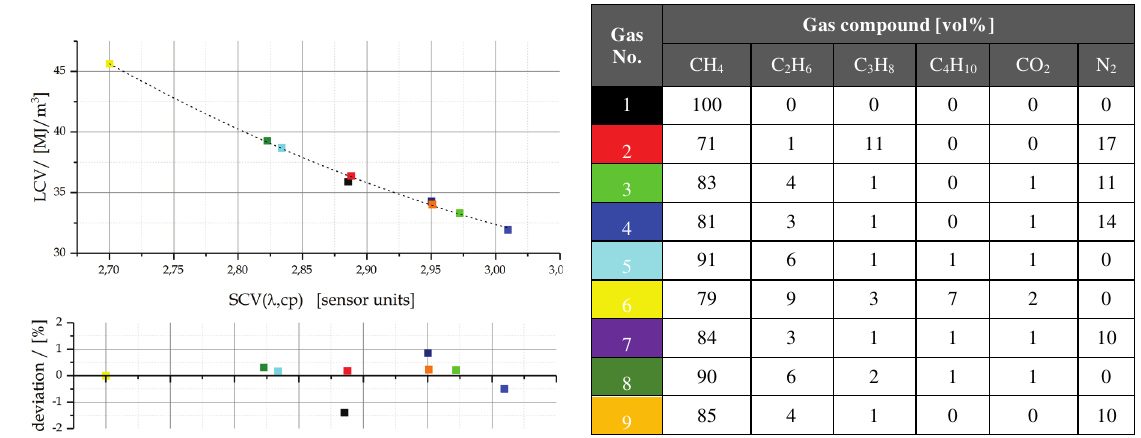
Fig. 5. Result of the theoretical correlation for the lower calorific value over a set of gas blends